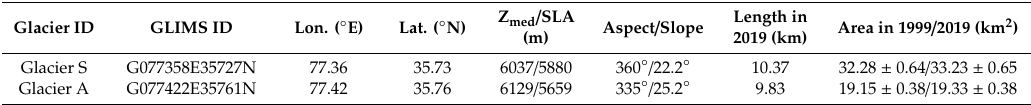
Table 1. Attributes of the two studied glaciers. Glacier areas are detected based on the images of 17 August 1999 and 3 October 2019. Longitude and latitude represent the central position of the glaciers. Z med represents median elevation and SLA represents snowline altitude in